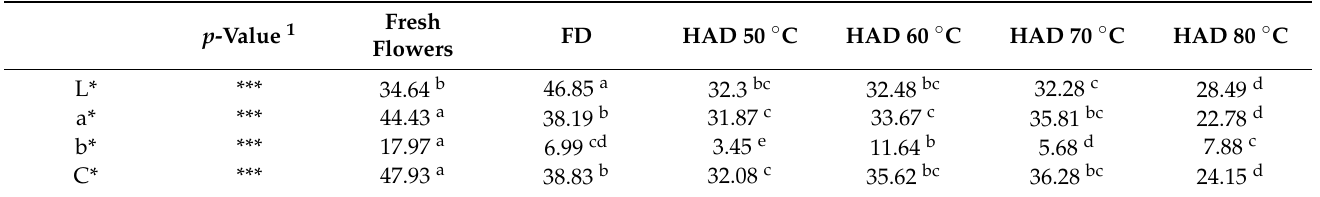
Table 1. CIE L*a*b* color parameters of the B. cucullata flowers subjected to different postharvest treatments. Abbreviation: FD—freeze-dried; HAD—hot-air dried.